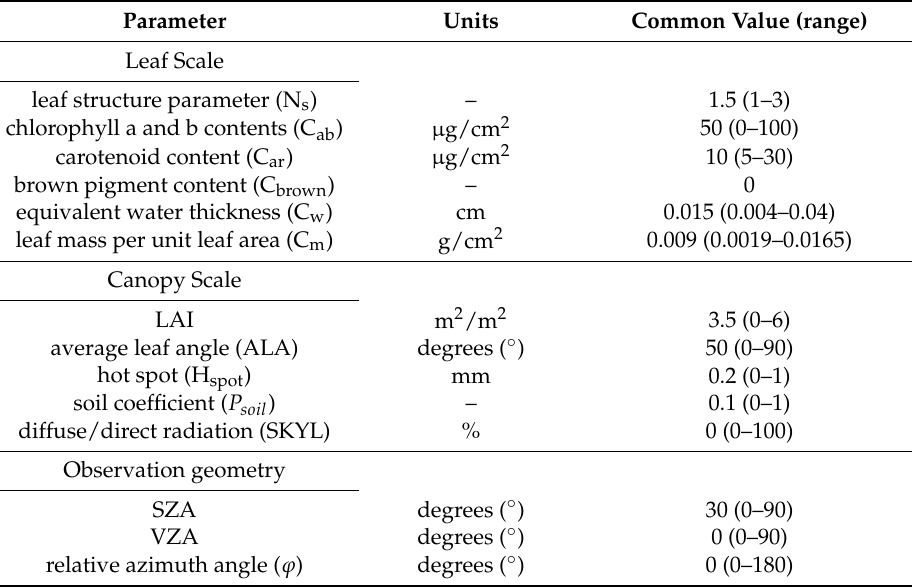
Table 1. The input parameters of the PROSAIL